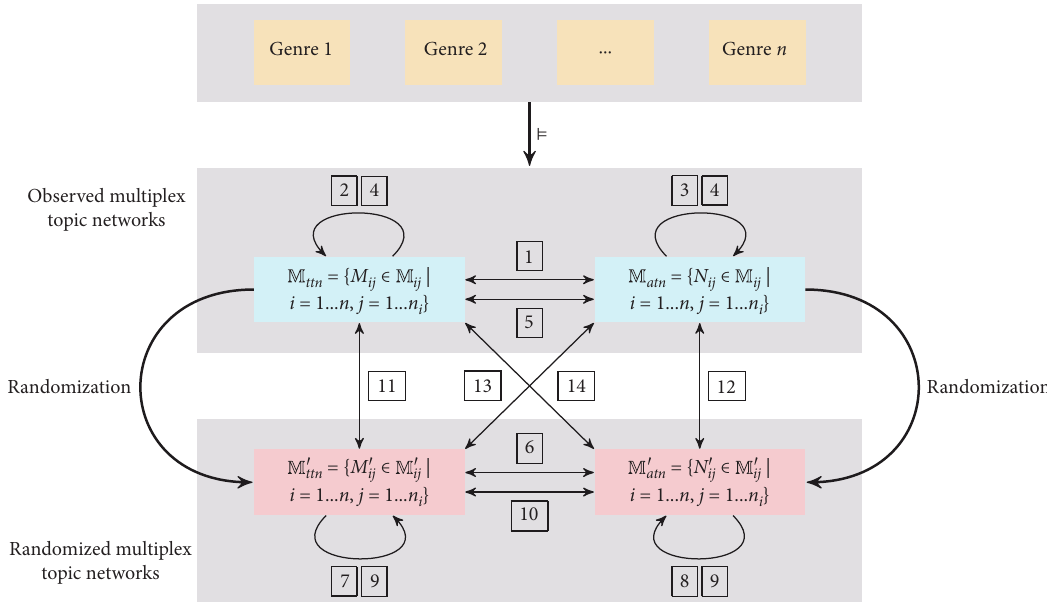
Figure 16: From sets of corpora of different genres to multiplex topic networks and their randomizations: corpora of different genres are the starting point for spanning LMNs which are then used to derive two-layer multiplex topic networks ( ⊧ ). In a second step, randomized counterparts according to Section 3.2.4 are derived from these MTNs to obtain a further basis for evaluating their significance. In this way, we arrive at fourteen candidate scenarios for classifying topic